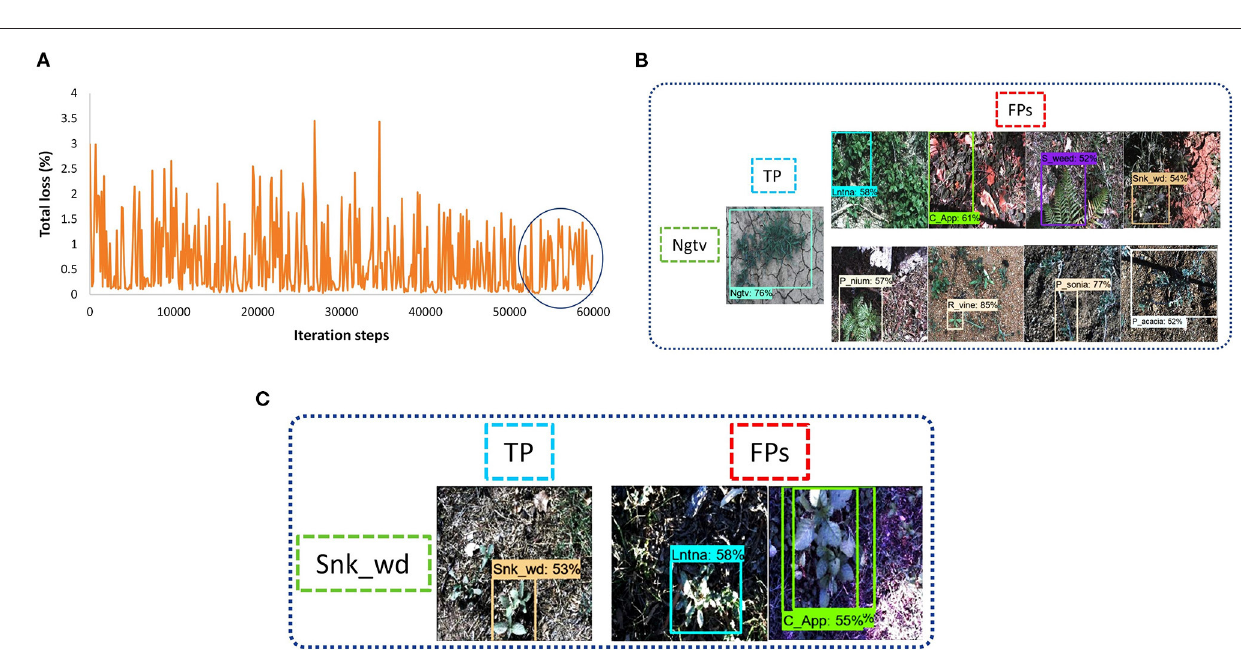
the best image resizing method was found considering bilinear interpolation as the default method. It led to the application of three other interpolation methods. An overall mAP